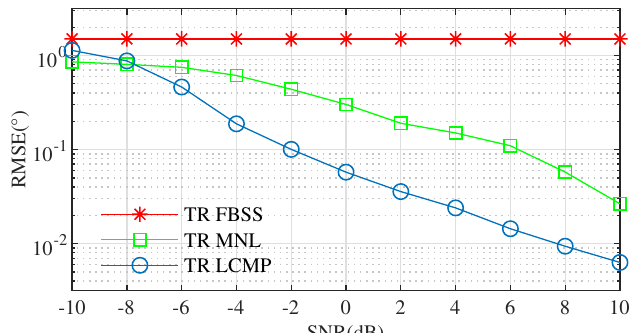
Figure 2. RMSE of the three algorithms versus